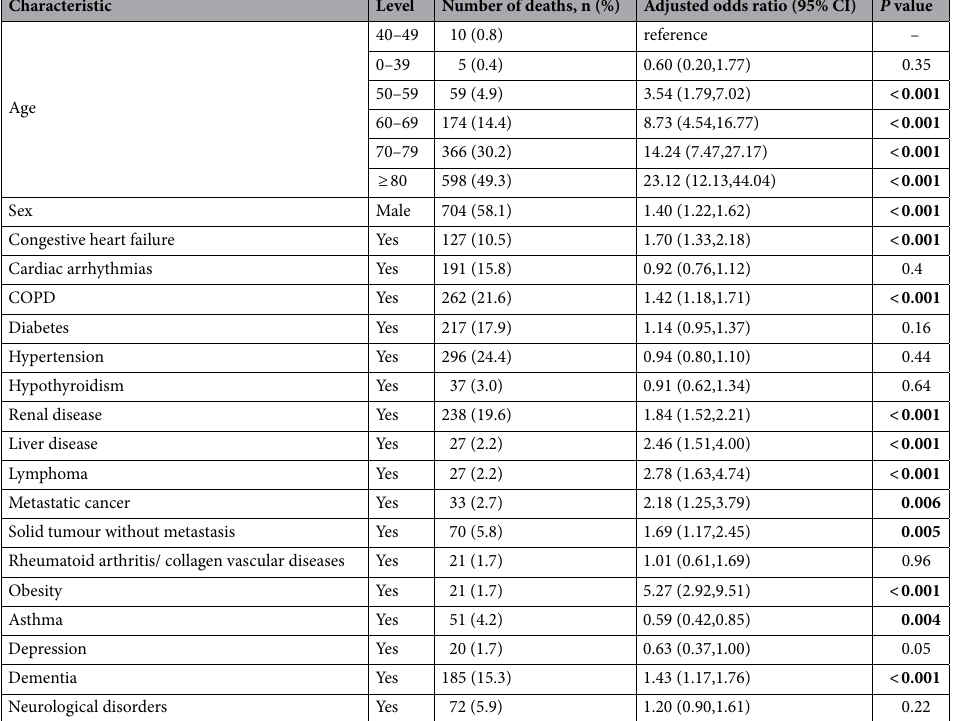
Table 5. Sensitivity analysis for the association between pre-existing health condition and in-hospital mortality in patients with COVID-19. COVID-19-related deaths were defined as COVID-19 related admissions with ICD-10 code diagnosis, including only primary or secondary diagnosis code of U07.1. Statistically significant P < 0.05 values are in bold. Observations, n = 5955 including 1212 COVID-19 deaths. CI Confidence